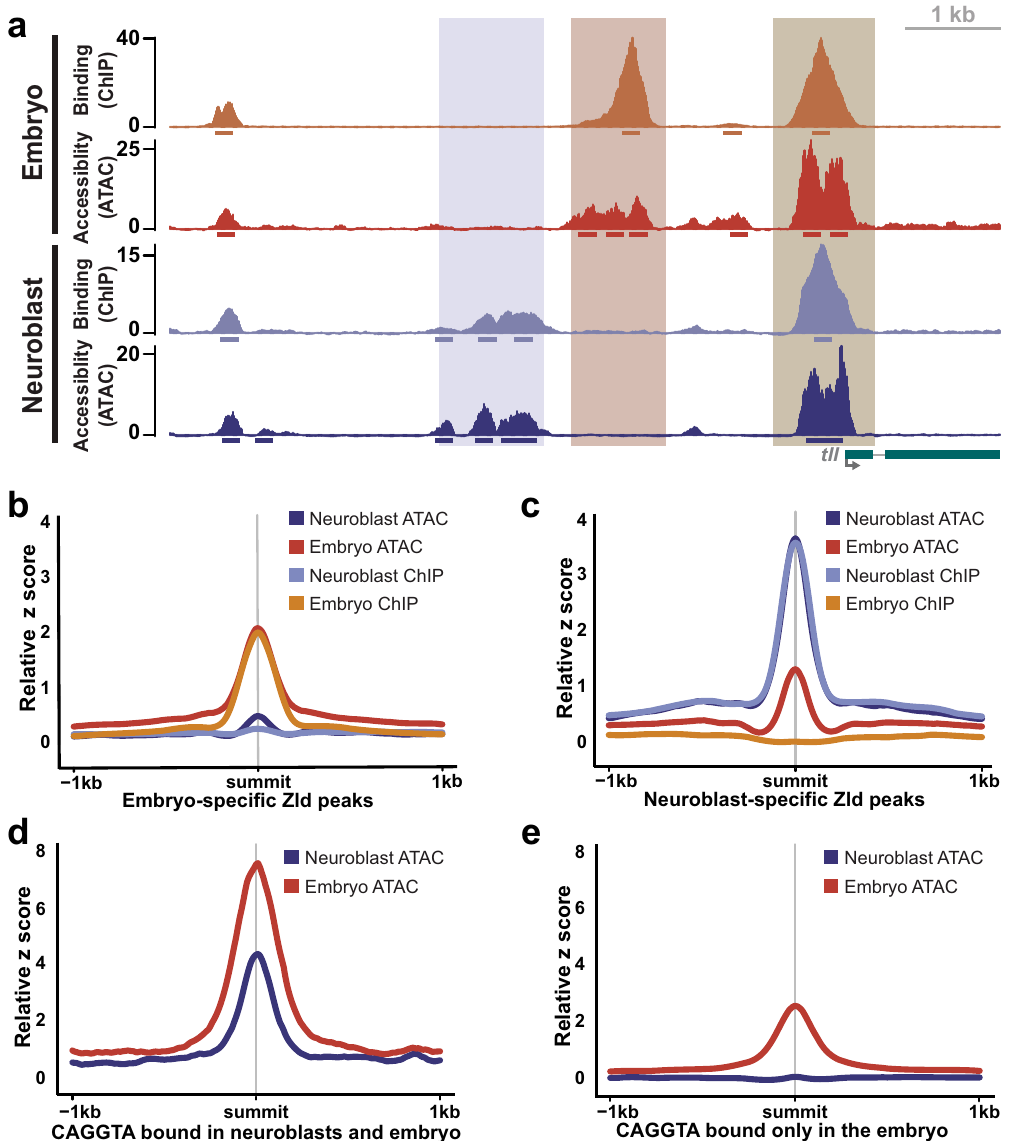
Fig. 5 Cell-type-speci fi c differences in chromatin accessibility correlate with cell-type-speci fi c Zld binding. a Genome browser tracks of Zld binding (ChIP-seq) and chromatin accessibility (ATAC-seq) in stage 5 embryos and type II neuroblasts of brat 11/Df(2L)Excel8040 brains at the tll locus. Peak regions are indicated below the tracks. Highlighted areas indicate regions bound by Zld and accessible only in neuroblasts (blue), only in embryos (orange) and in both (brown). b, c z score for ChIP-seq and ATAC-seq centered on Zld ChIP-seq peaks speci fi c to the embryo ( b ) or Zld ChIP-seq peaks speci fi c to the type II neuroblasts ( c ). d, e z score for ATAC-seq from the embryo and type II neuroblasts centered on the shared Zld ChIP-seq peaks containing a CAGGTA motif ( d ) or Zld ChIP-seq peaks speci fi c to the embryo containing a CAGGTA motif ( e